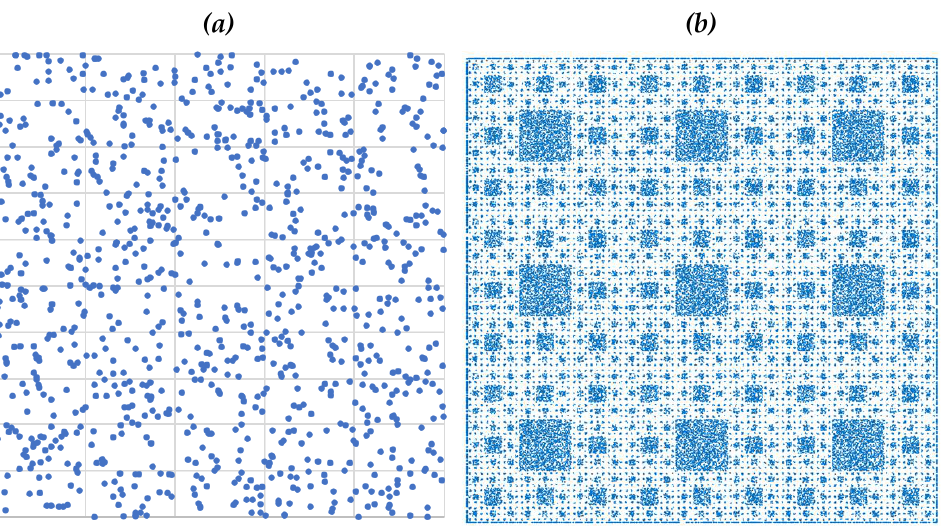
Figure 9. Filling pores using a random filler point cloud: ( a ) a random filler point cloud; and ( b ) the fifth level point cloud after filling operation by filler point cloud ( a ).